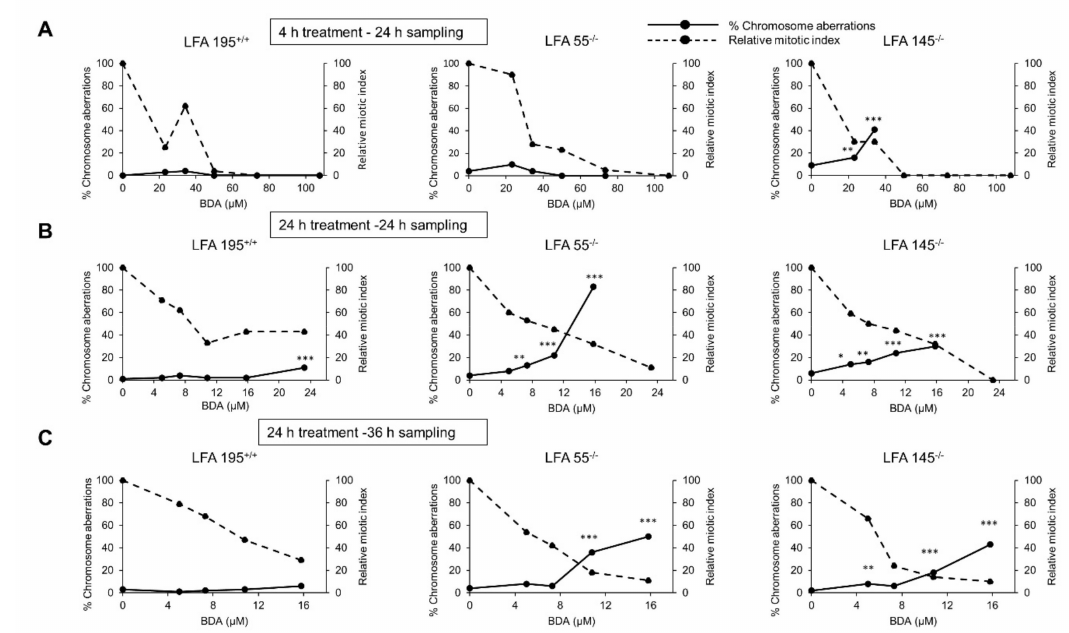
Figure 5. Chromosomal aberrations induced in the absence of S9 metabolism by BDA in immortalized lymphoblastoid cell lines originated from a normal individual (LFA195 +/+ ) or from patients with FA (LFA55 − / − or LFA145 − / − ) with different mutations in the FANCA gene (see M&M). ( A ) Treatments performed for 4 h and sampling of cells at 24 h from the beginning of treatment; ( B ) Treatments performed for 24 h and sampling of cells at 24 h from the beginning of treatment; ( C ) Treatments performed for 24 h with a recovery period of 12 h and sampling of cells at 36 h from the beginning of treatment in order to assess DNA repair in normal and FA lymphoblastoid cell lines. * p < 0.05; ** p < 0.01; *** p < 0.001.